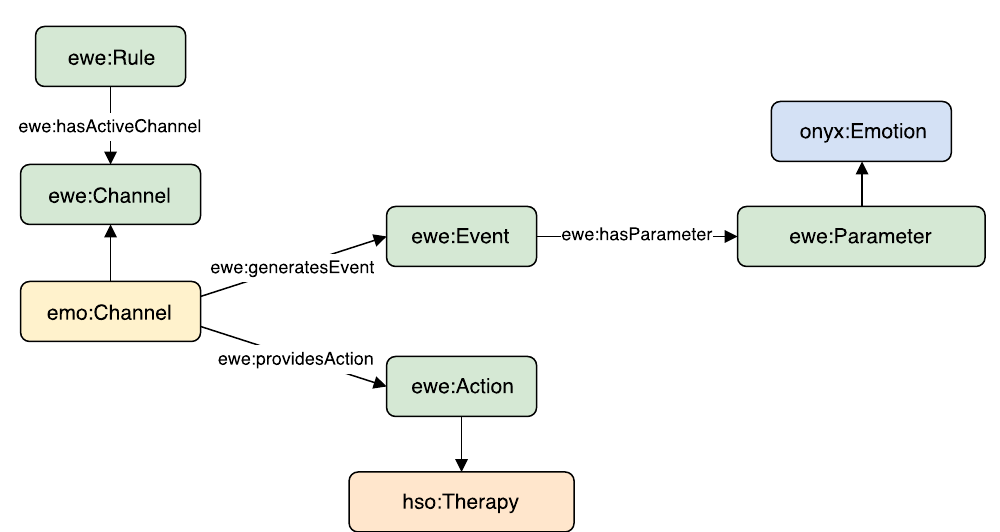
Figure 1. Main classes of the ontologies involved in the semantic